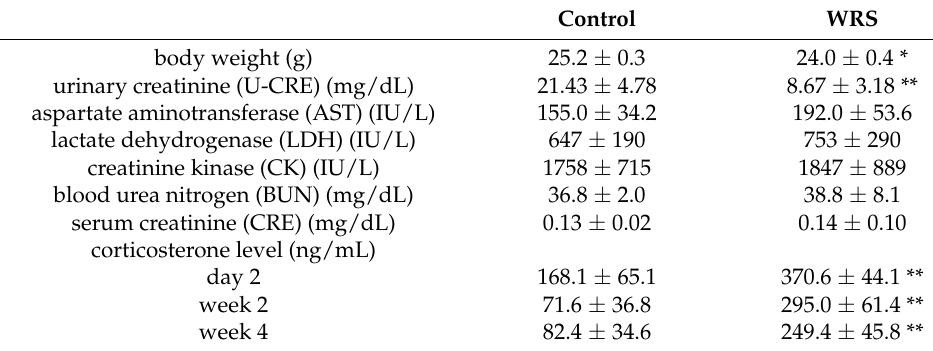
Table 2. Influence of WRS on mice growth.